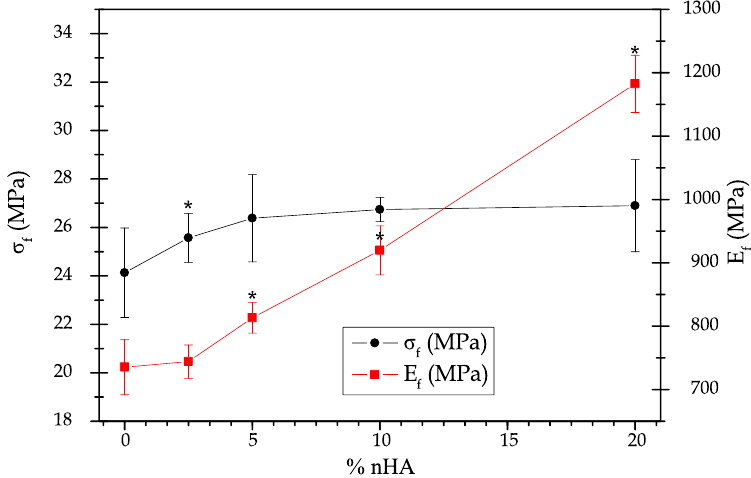
Figure 2. Evolution of the maximum flexural stress ( σ f ) and flexural modulus (E f ) in the injection-molded parts of poly(3-hydroxybutyrate- co -3-hydroxyhexanoate) [P(3HB- co -3HHx)] with the content of hydroxyapatite nanoparticles (nHAs). * Indicates a significant difference compared with the previous sample ( p < 0.05)